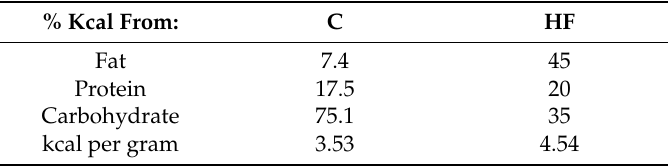
Table 1. Energy content of the diets. % Kcal